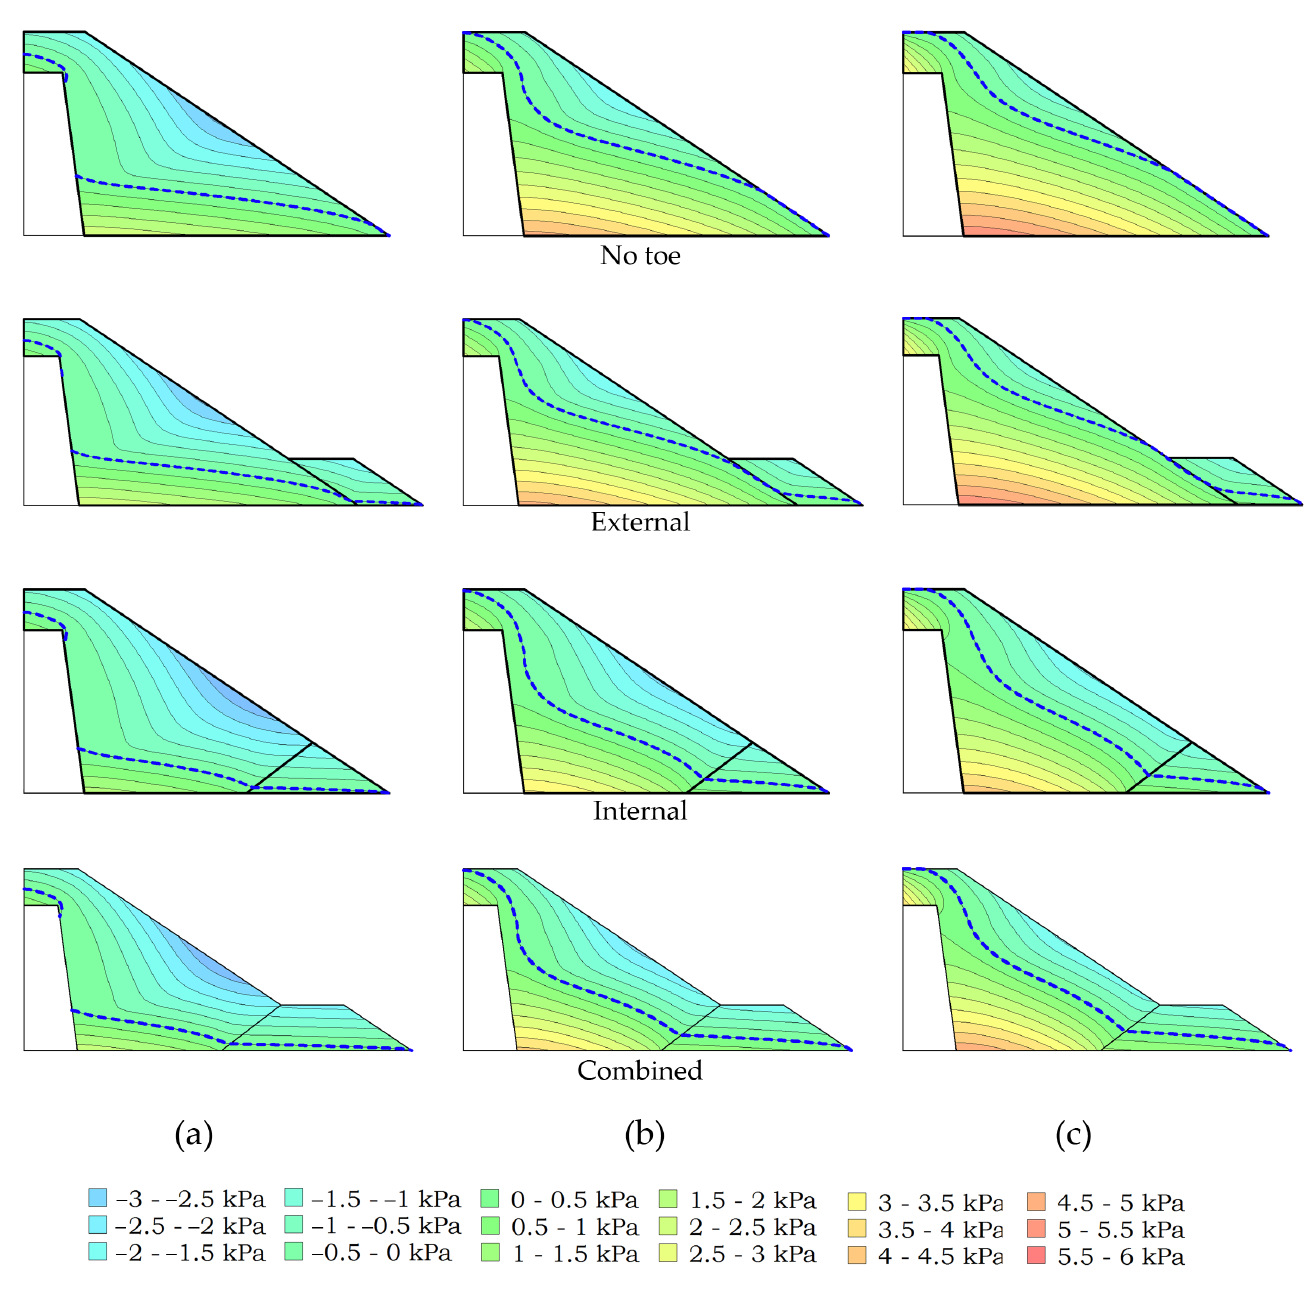
Figure 9. Numerical modeling results for the four toe configurations; column ( a ) shows results for q = 1.0 × 10 − 3 m 3 /s, column ( b ) q = 2.0 × 10 − 3 m 3 /s and column ( c ) q = 4.0 × 10 − 3 m 3 /s. The colored contours display the water pressure shown in the legend, while the phreatic surface is displayed as the dotted blue